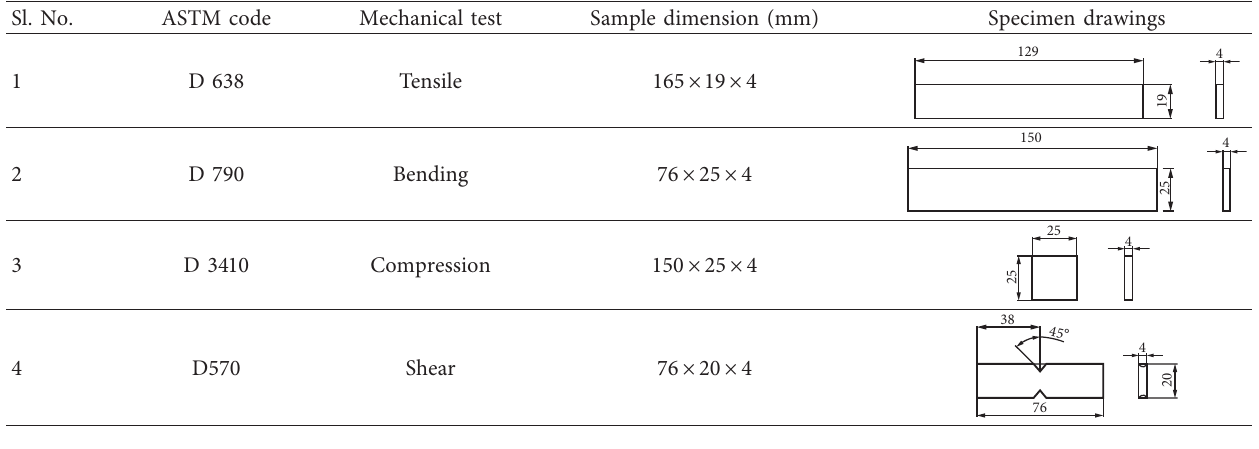
Table 4: ASTM standard specimen dimensions.